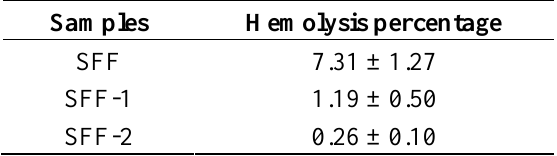
Table 3. Hemolysis percentage of untreated and modified silk fibroin